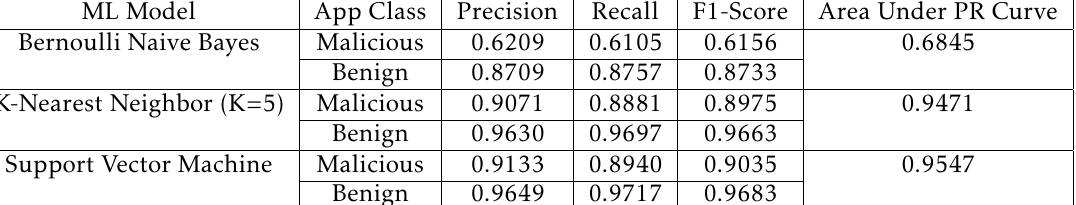
Table 6. Accuracy of standard ML algorithms